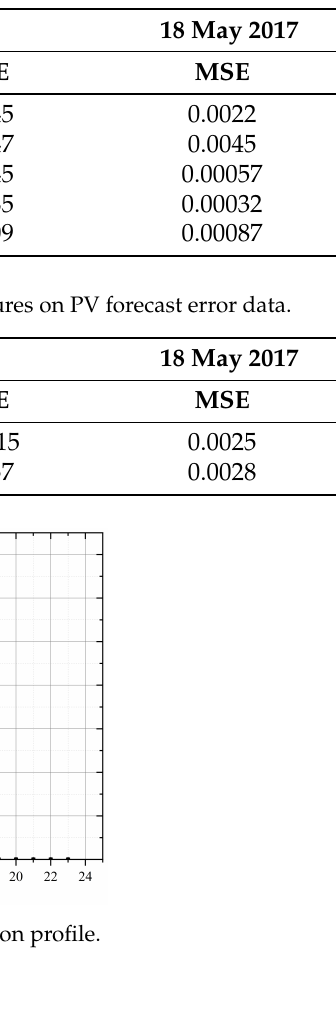
Table 3. Prediction performance measures on individual users’ load forecast error data.